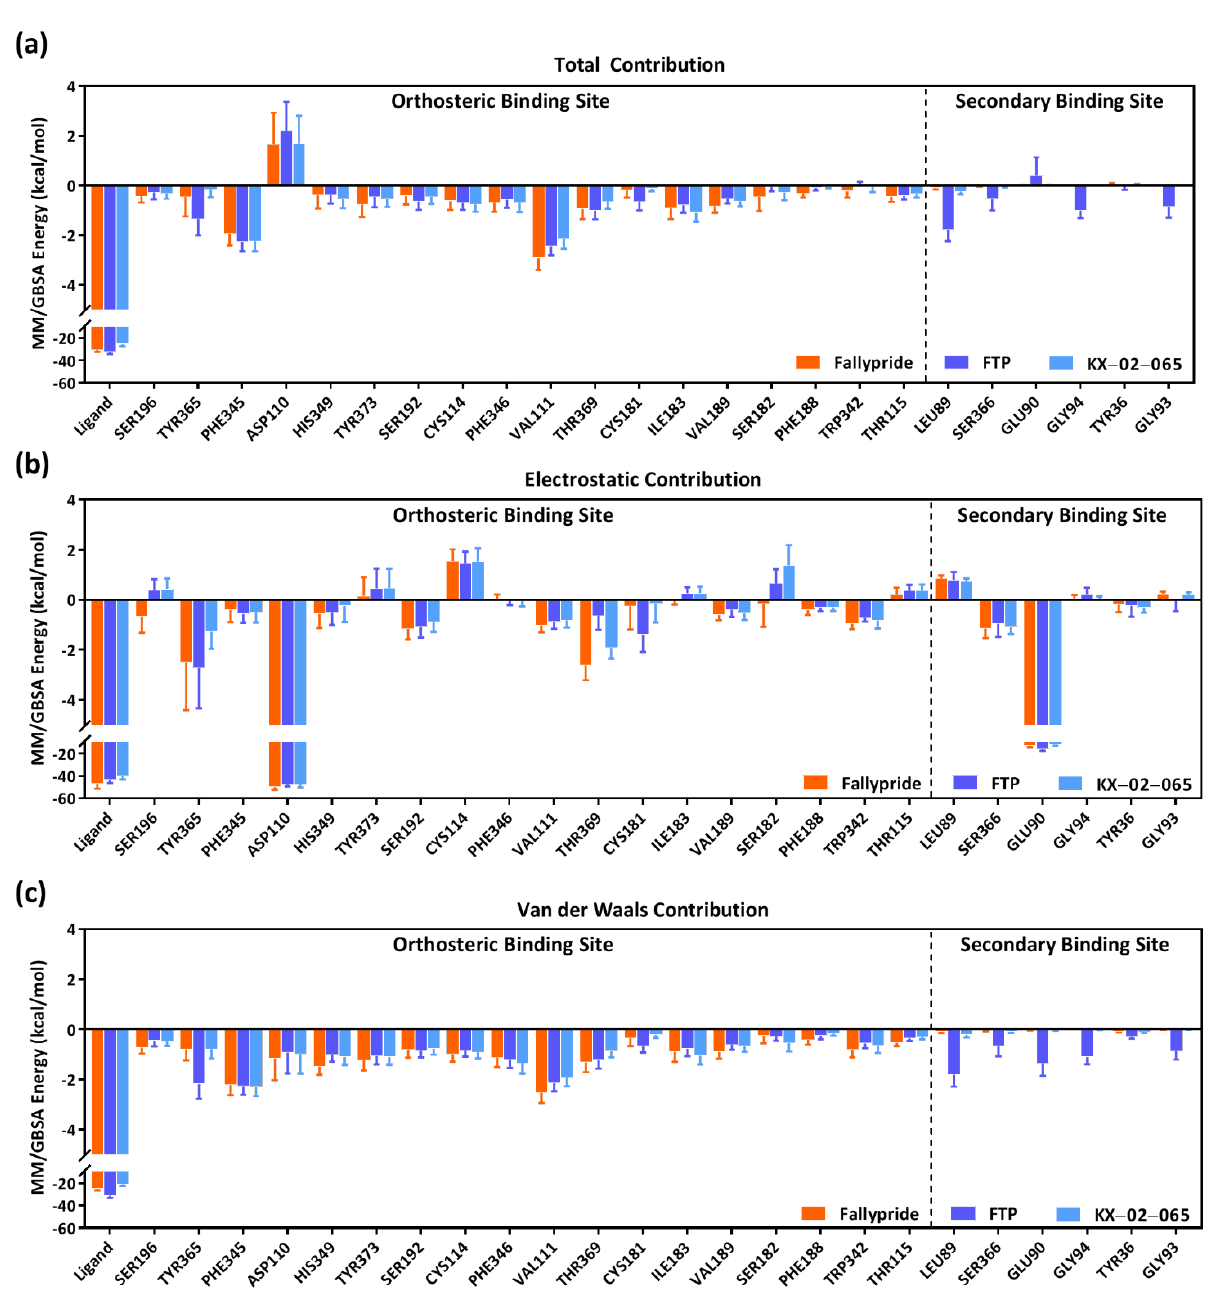
Figure 5. ( a ) Total MM/GBSA binding free energy (kcal/mol) contribution of each residue in the binding pocket, ( b ) MM/GBSA electrostatic (kcal/mol) contribution of each residue in the binding pocket, and ( c ) MM/GBSA van der Waals (kcal/mol) contribution of each residue in the binding pocket.